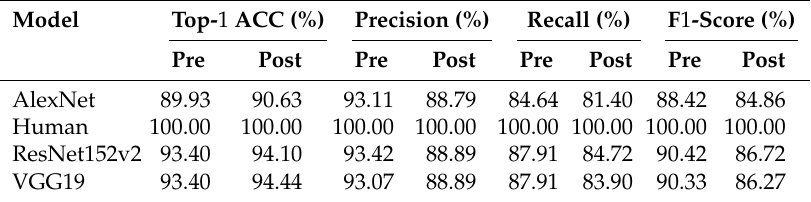
Table 7. Metrics of ENG human subjects and the selected deep neural networks AlexNet [55], VGG19 [56], and ResNet152v2 [57] on the pre-CRT (original) and post-CRT (changed) ILSVRC2012 subset D (cid:48) .